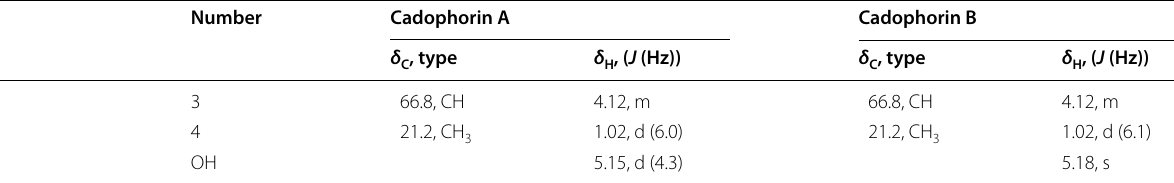
Table 2 Table retention times (R